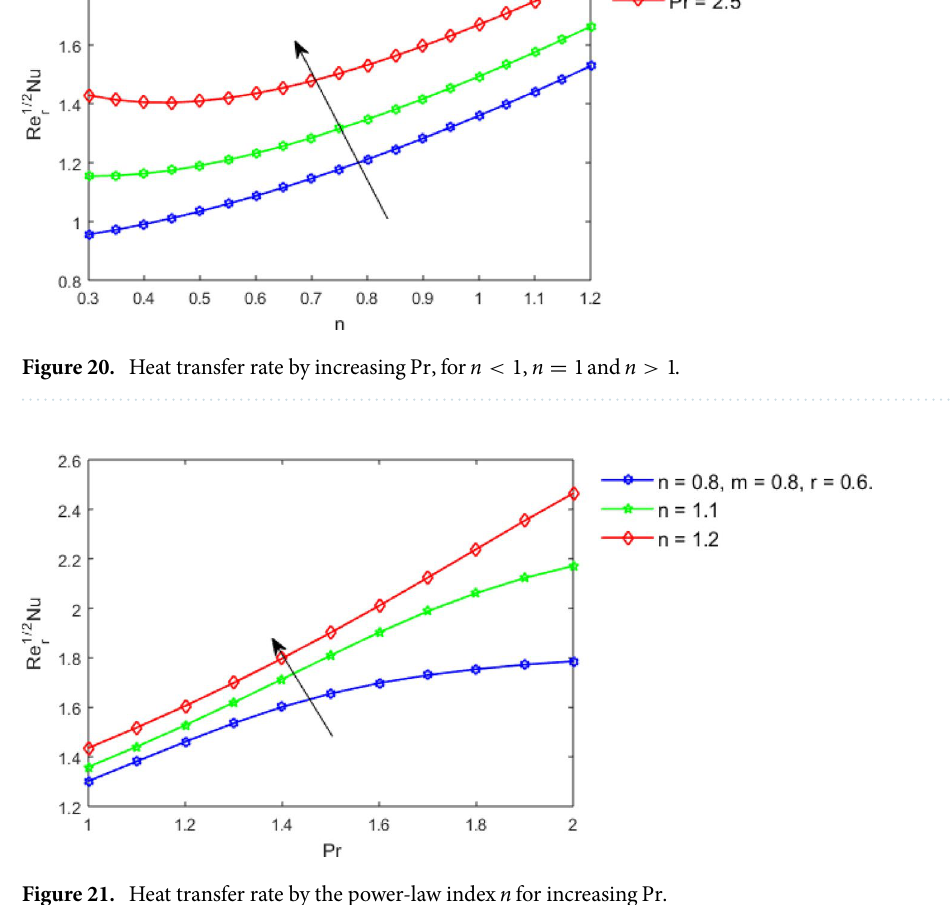
) for Newtonian fluid with thickness index of disk h ( − ∞ 0 and Pr 2, r 0.6 . vs = = =